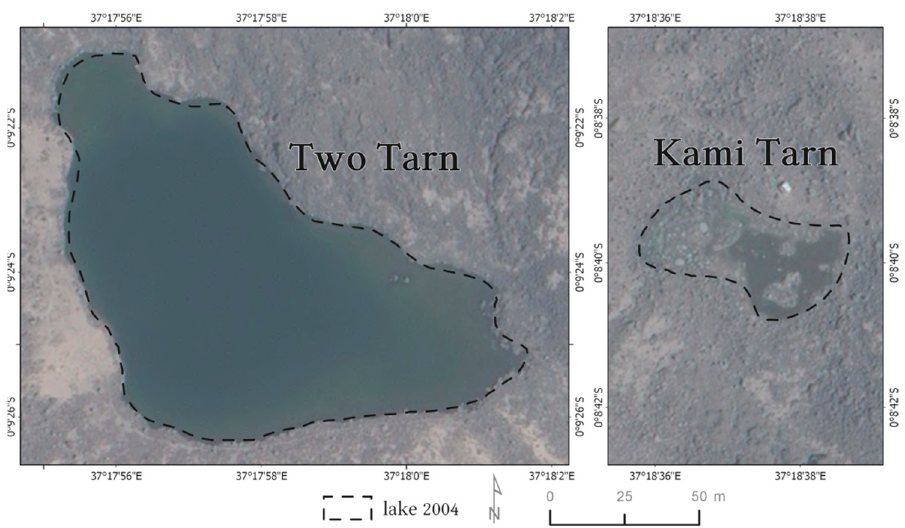
Figure 4. Comparison of the shorelines of two tarns on Mt. Kenya indicating the generally good alignment between the Pléiades orthophoto and the map of 2004, but also one misalignment in the case of shallow Kami